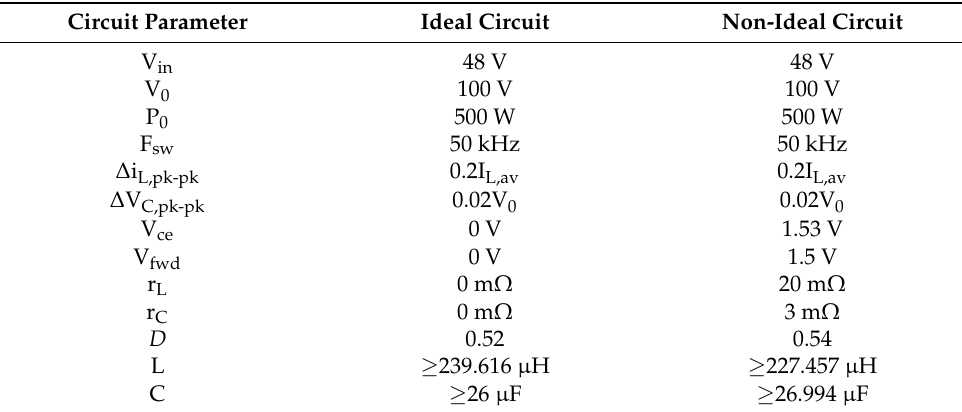
Table 1. Converter parameters to evaluate effects of non-ideal